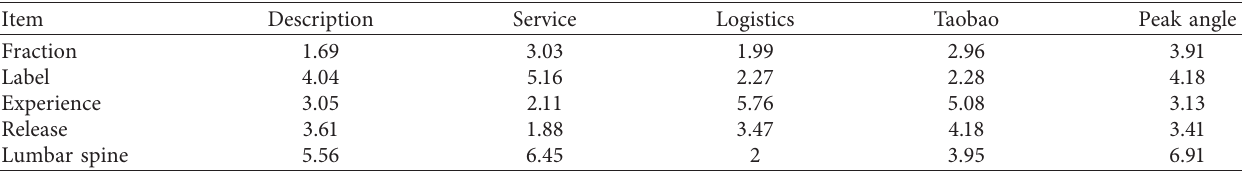
Figure 6: Trading platform score service indicators. Table 3: User star rating to calculate the discount rate and display it on the page.